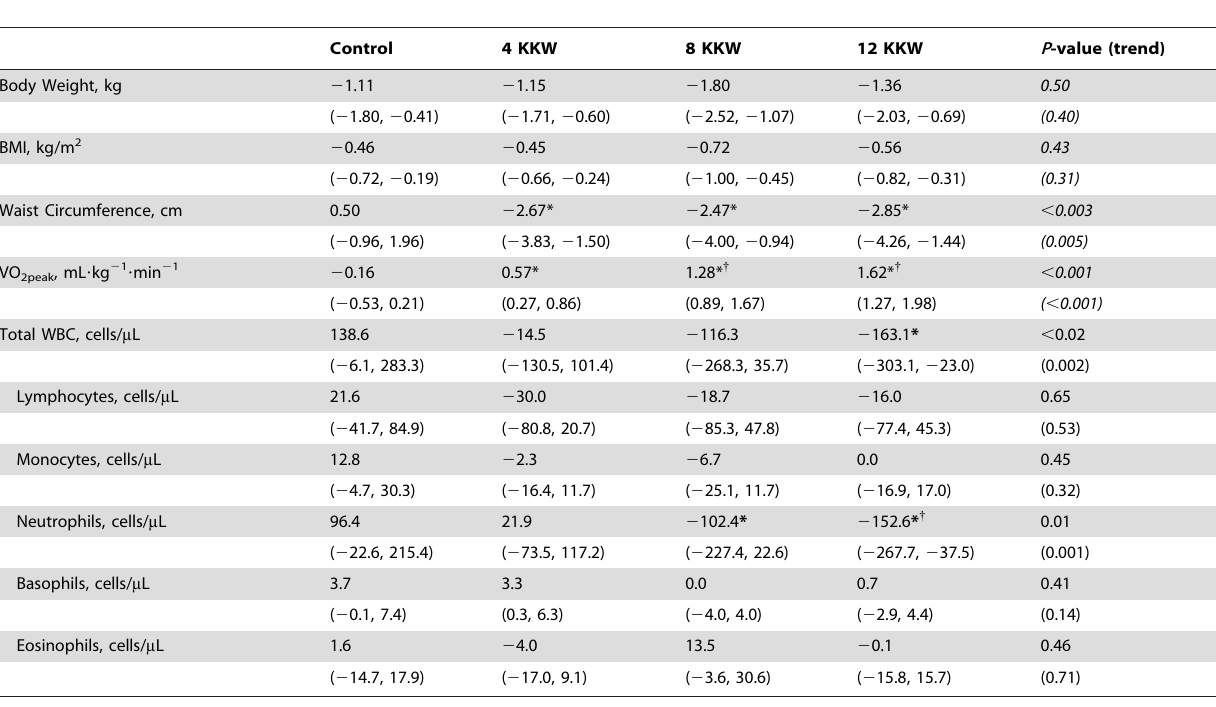
Table 2. Mean (95%CI) change in anthropometric and fitness data and total WBC and WBC subfraction counts after 6 months of intervention.